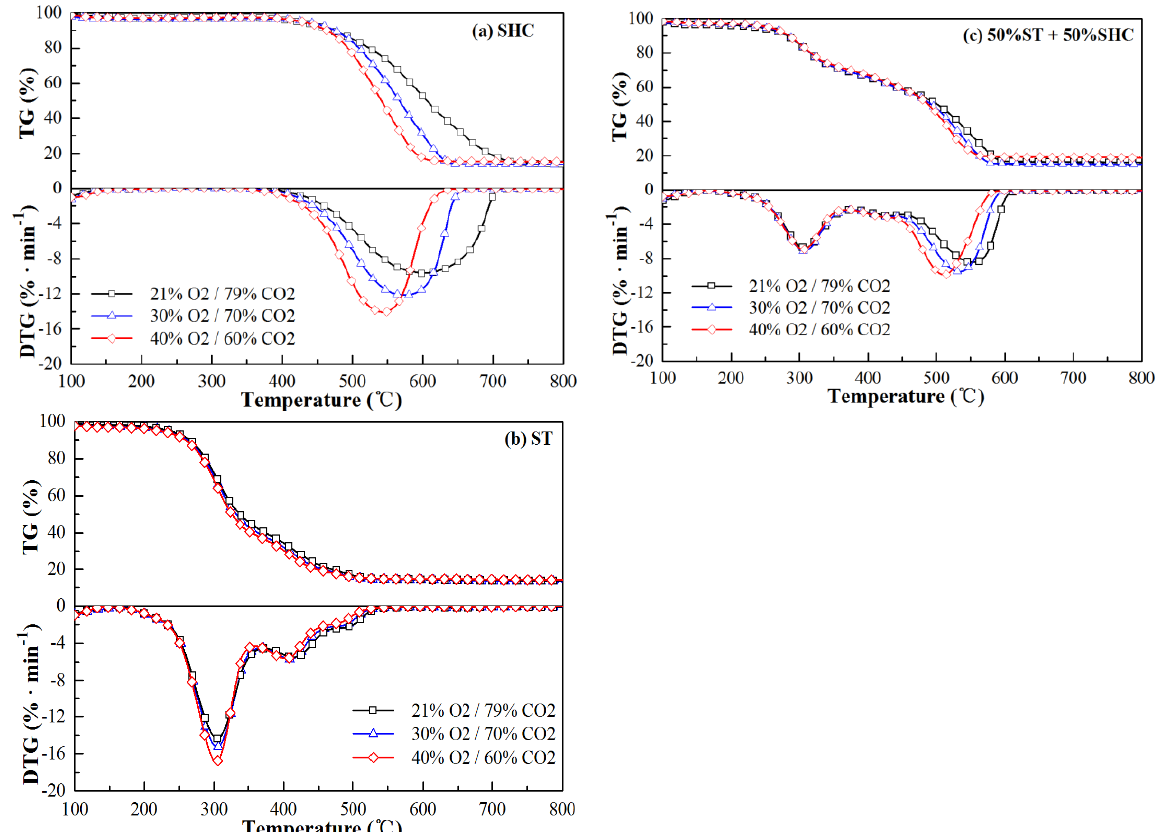
Figure 5. TG and DTG curves of SHC, ST and 50% SHC + 50% ST under different O 2 concentrations.